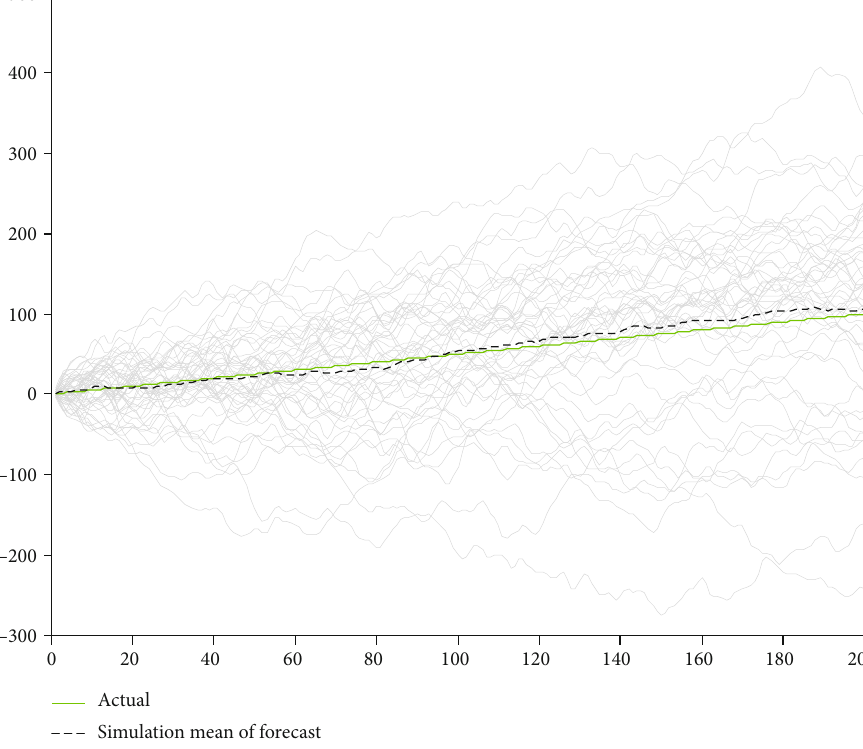
Figure 7: Observations from ensemble model for larger PV